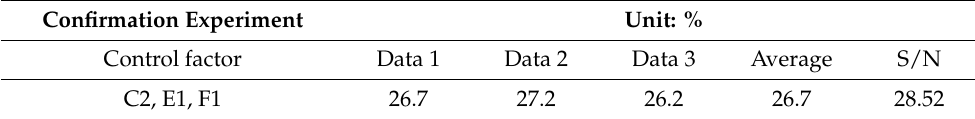
Table 14. The confirmation experiment of the elongation at